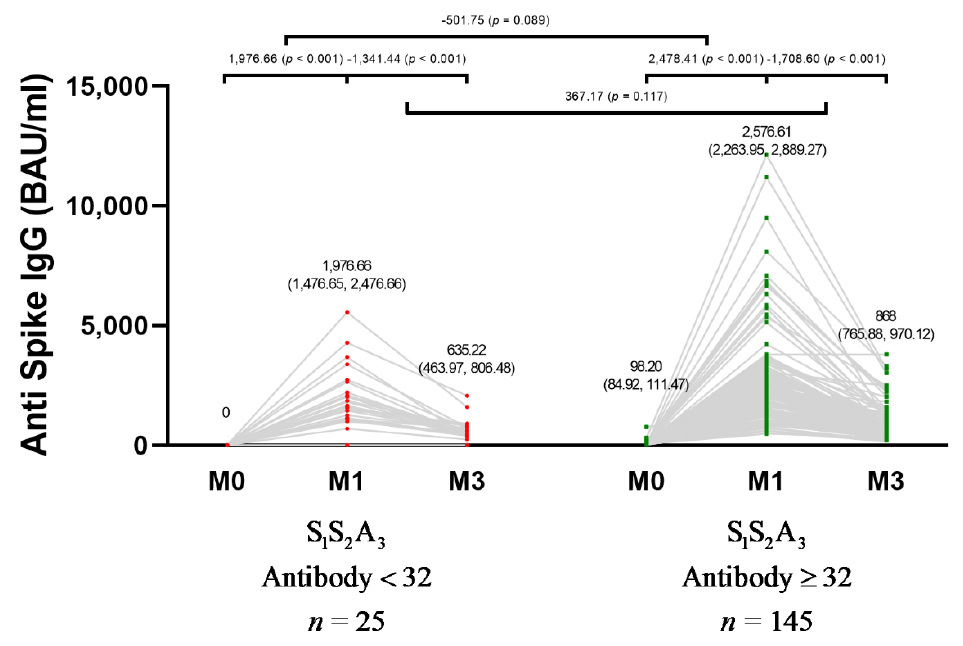
Figure 2. Change in anti-spike IgG level in 170 participants after received ChAdOx1 nCoV-19 as the third dose following two doses of CoronaVac based on the baseline anti-spike IgG status. Anti-spike IgG level reported as BAU/mL was measured before ChAdOx1 nCoV-19 vaccination (baseline), 1 month post-vaccination, and 3 months post-vaccination. BAU: binding antibody units; IgG: immu-